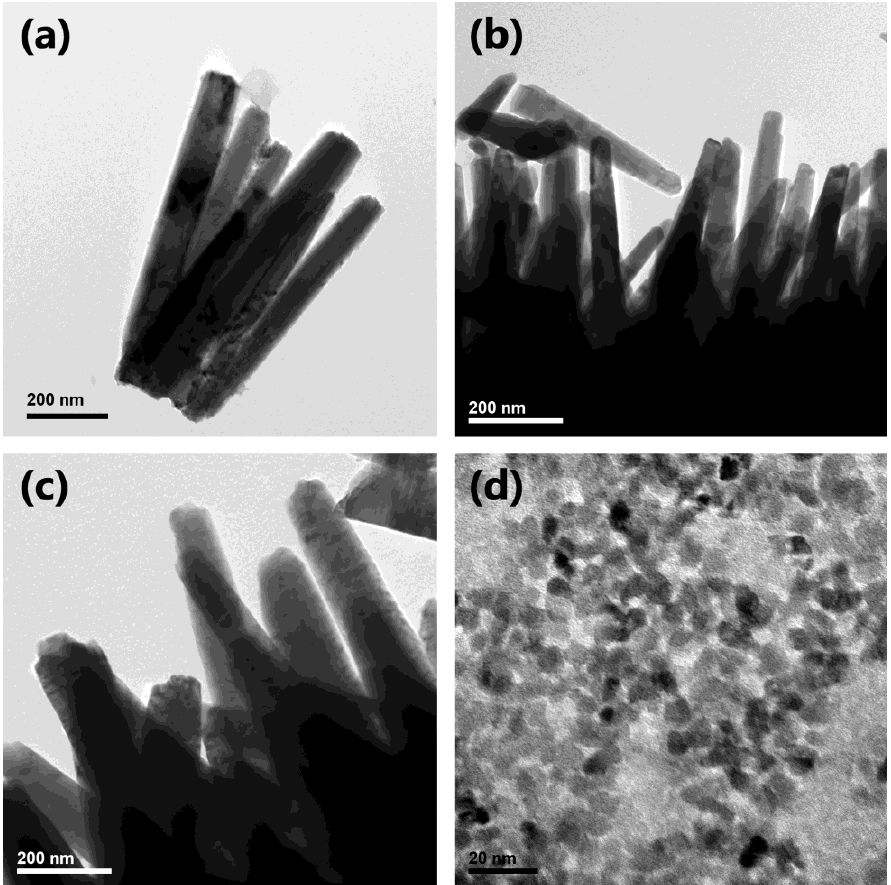
Figure 2. Bright field TEM images of the ZnO nanorods grown in 0.5% formamide for each of the three procedures A ( a ), B ( b ) and C ( c ) and of ZnO nanoparticles used for the spin-coating seed layer ( d ).